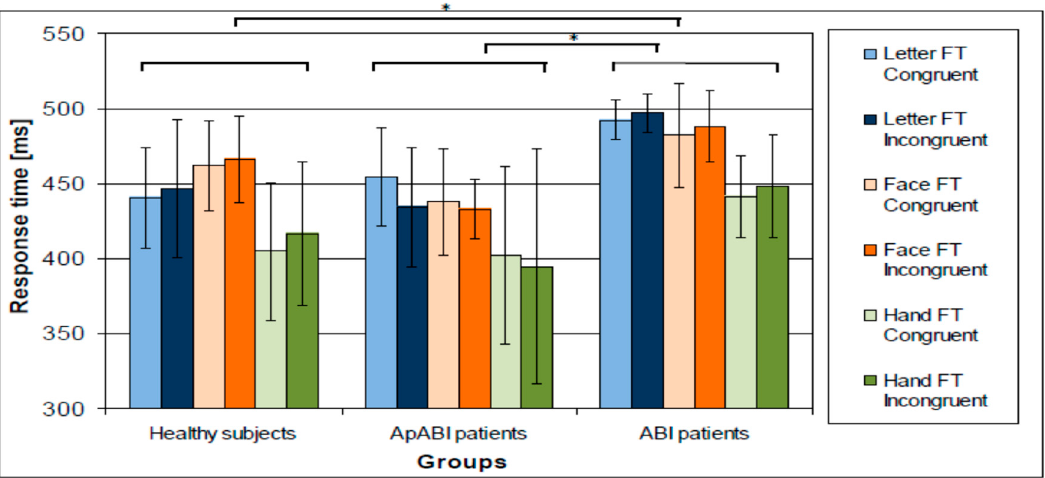
Figure 5. RT mean (higher values correspond to slower responses) for healthy subjects, ApABI and ABI patients in the letter (blue), face (orange), and hand (green) FT, in the congruent (light color) and incongruent (dark color) trials. * stands for p ≤ 0.05